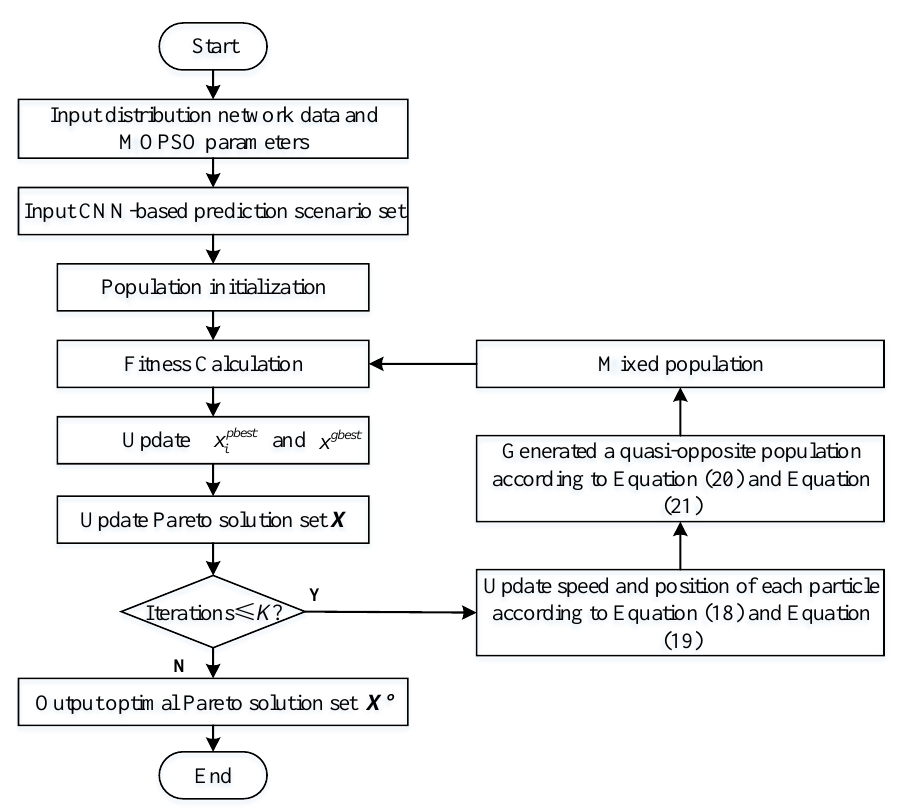
Figure 4. Flow chart of the model solution based on the improved MOPSO algorithm.